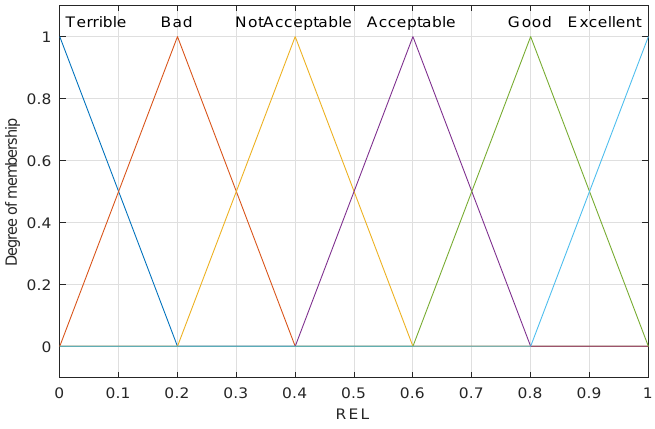
Figure 6. Membership function of REL.